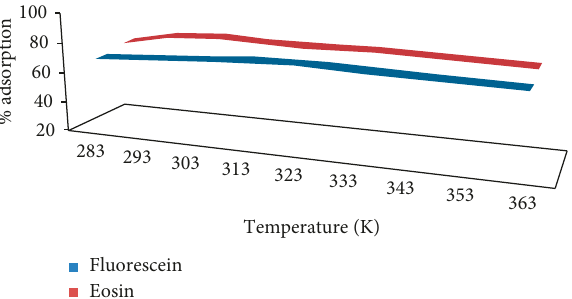
Figure 7: Comparative sorption efficiency of base-treated WMP at different temperatures for removing fluorescein and eosin dyes.